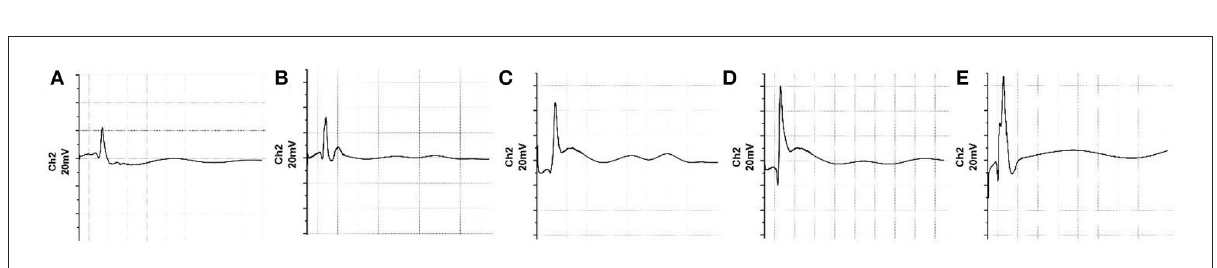
FIGURE6 Electromyograph of the nerve regeneration at 12 weeks post-implantation. (A) Hollow group. (B) RAD/KLT group. (C) RAD/IKVAV group. (D) RAD/KLT/IKVAV group, and (E) Autograft group.